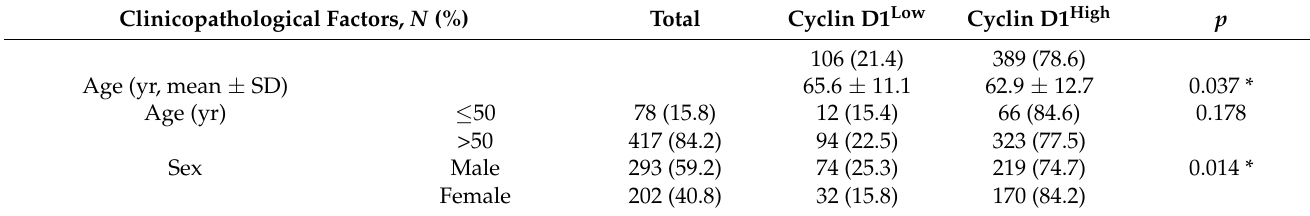
Table 2. Association between cyclin D1 expression and clinicopathological factors in 495 patients with